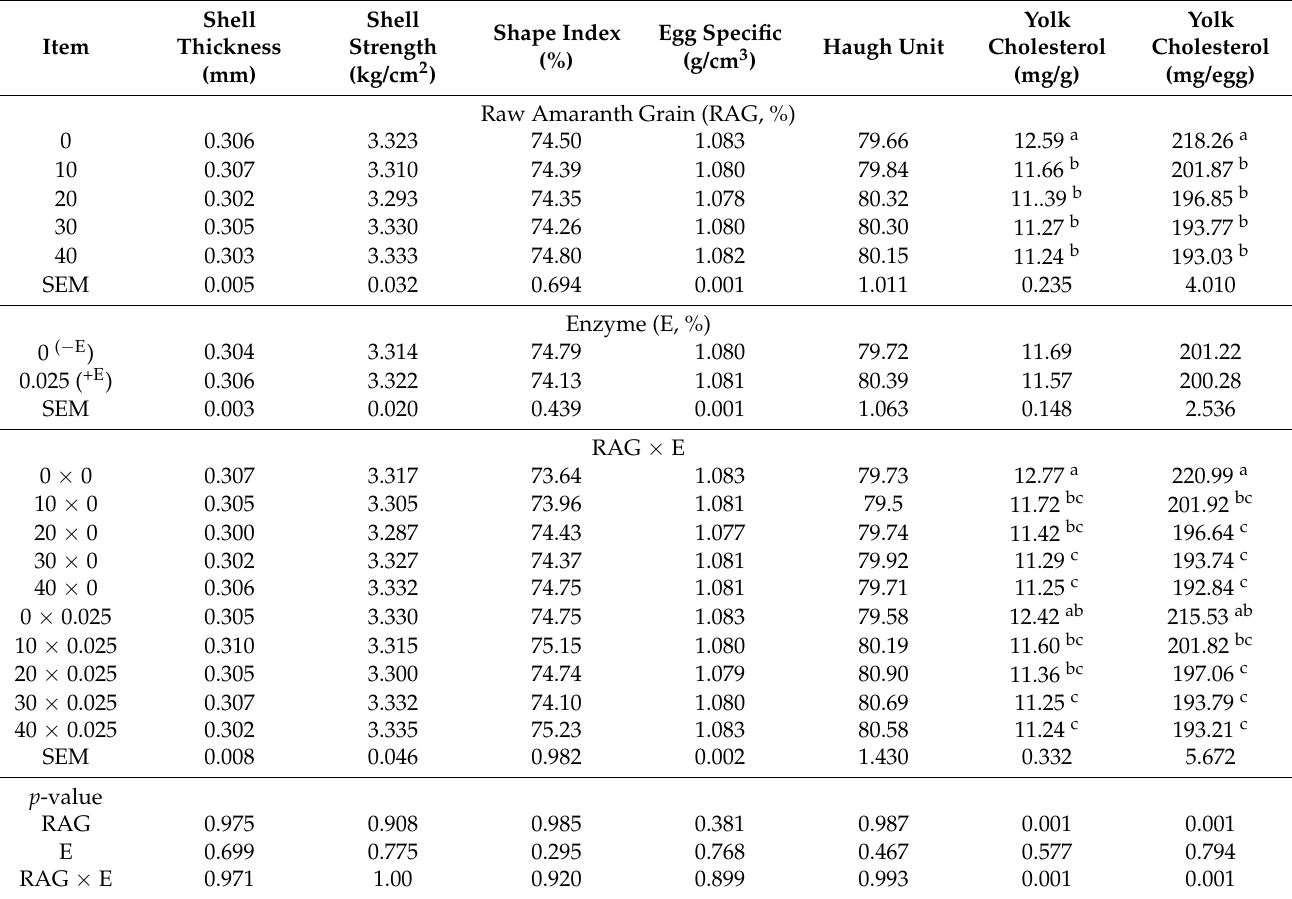
Table 5. Effect of experimental diets on egg quality traits and yolk cholesterol of laying